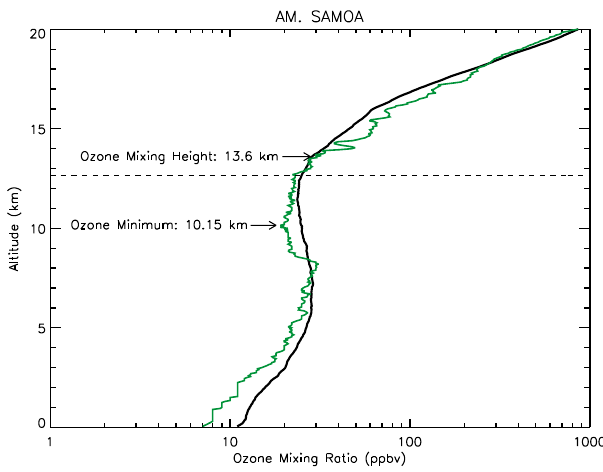
Fig. 4. The vertical ozone profile (green line) from 8 March 2006 at American Samoa demonstrating that ozone can remain relatively low over a layer of substantial thickness in the upper troposphere. The ozone minimum occurs at 10.15km and the ozone mixing height at 13.6km (corresponding to the maximum altitude ozone is less than 33.4ppbv – the seasonally average ozone concentration at the LNB). The seasonal mean (March-April-May) ozone profile is plotted with a black line. The horizontal dashed line indicates the seasonal mean height of the LNB.